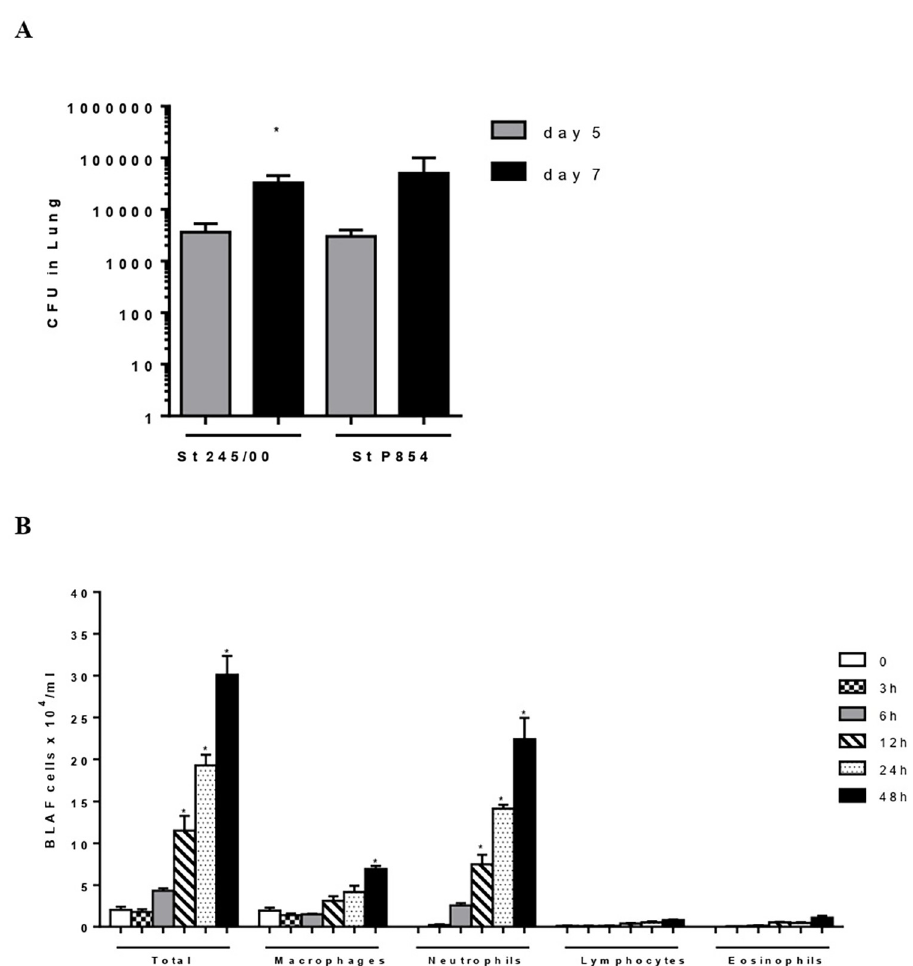
Fig 1. Mouse model of pneumococcal pneumonia. (A) Bacterial counts were determined in the lungs of nonimmunized mice on days 5 and 7 after intranasal inoculation with pneumococcal strains St 245/00 (serotype 14) and P854 (serotype 19F). Values were compared for each strain after 5- and 7 days using Student t test ( � p < 0,05). (B). Leucocyte infiltrates in the BALF were calculated for different time points after intranasal challenge with pneumococcal strain St 245/00. Statistical analysis was performed using one way ANOVA with Dunnet’s posttest. � p < 0,05 in comparison with cells counts at 0